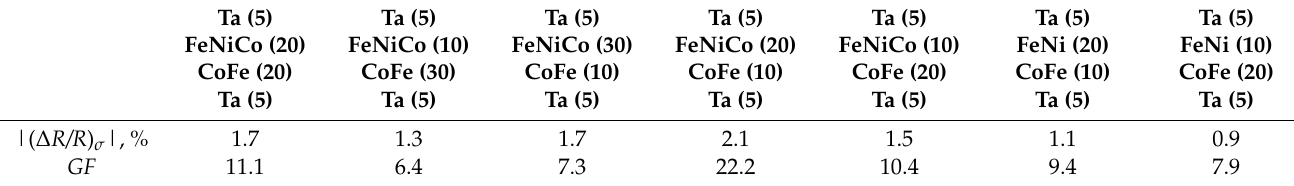
Table 3. Sensitivity of nanostructures to mechanical compressive/tensile stresses (layer thickness in nm).